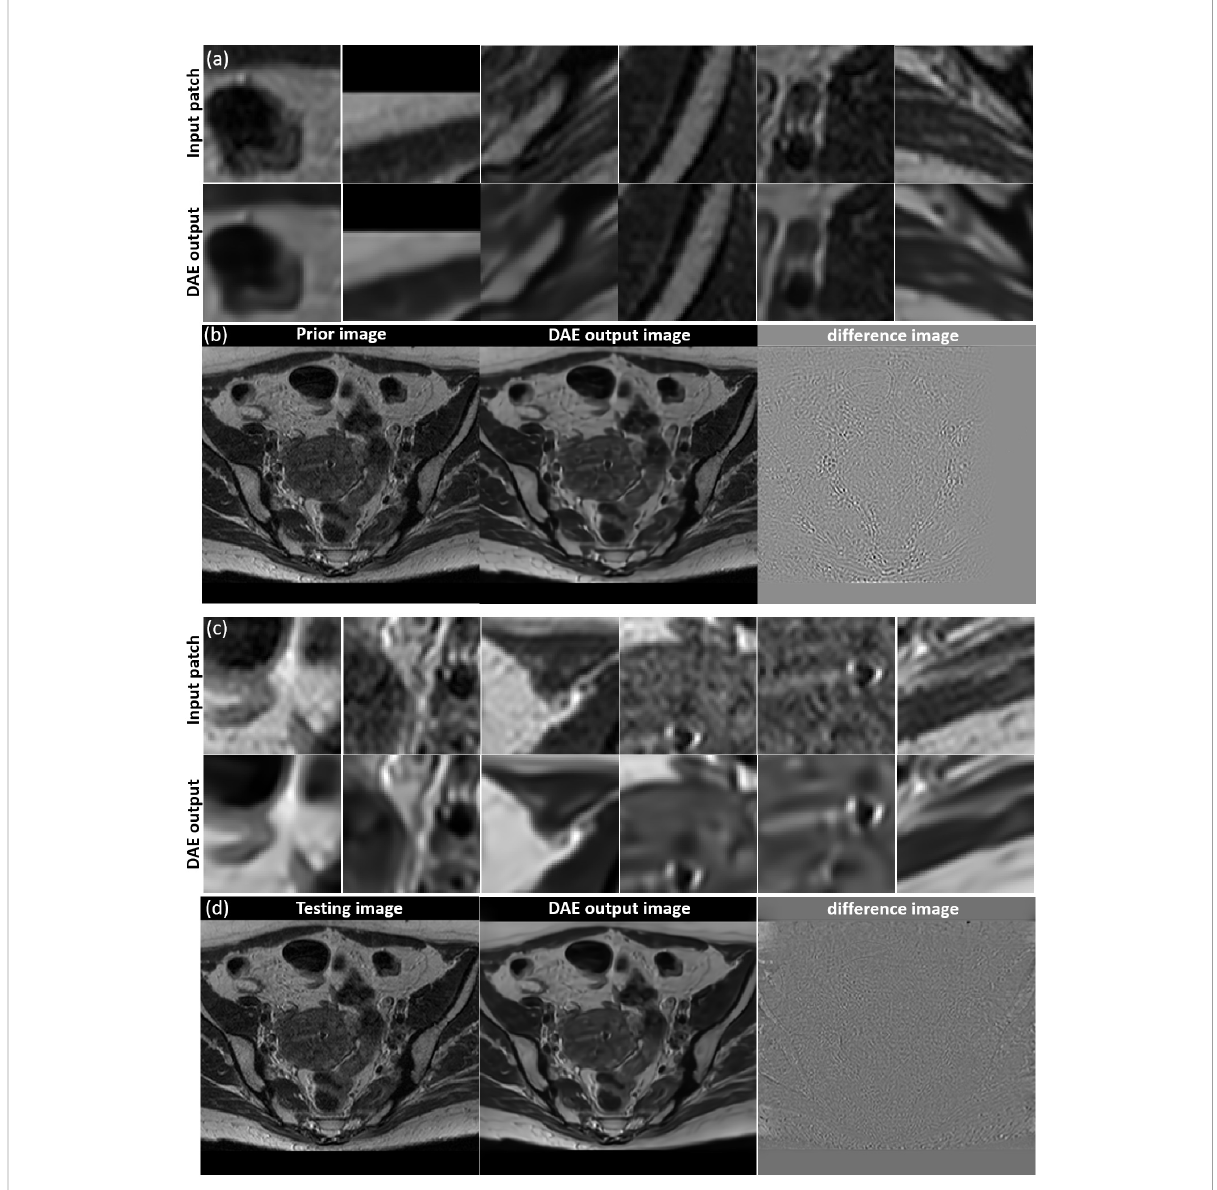
Figure 8. The advantages of the patient-speci fi c algorithm in terms of image quality became more obvious at